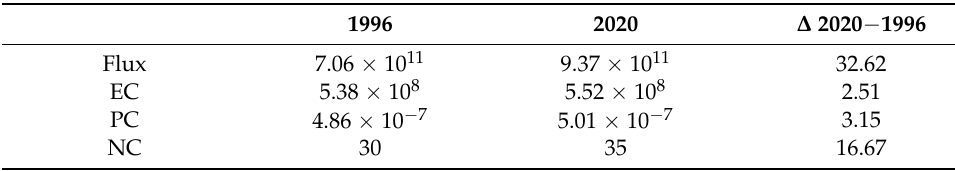
Table 5. Global connectivity in the years 1996 and 2020.